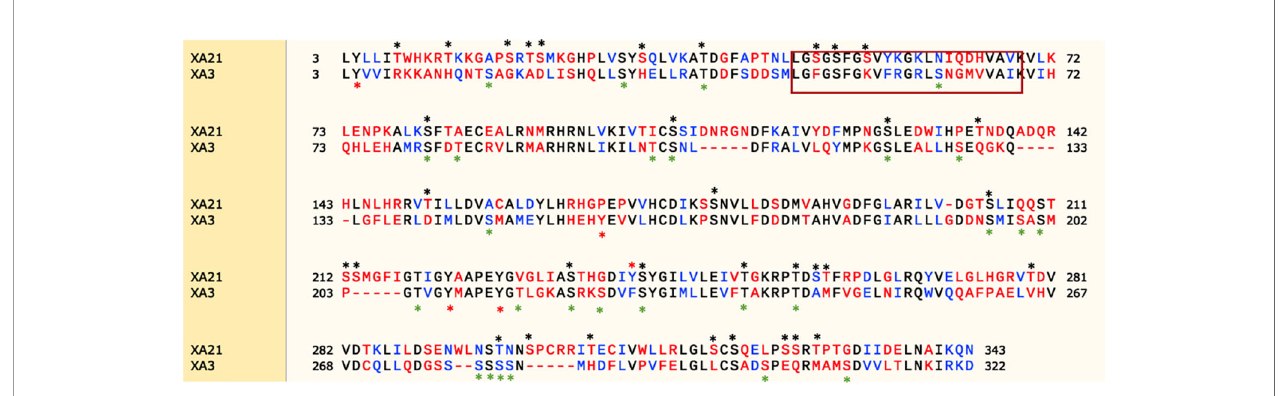
FIGURE 8 | Protein sequence alignment of the XA21 and XA3 intracellular kinase domains. Snapgene (SnapGene software from GSL Biotech; available at snapgene.com) was used for sequence alignment and NetPhos 3.1 (Blom et al., 2004) was used to predict the phosphorylation sites. The red box represents the predicted ATP binding domain. Predicted serine/threonine or tyrosine phosphorylation sites are marked with a “ * ” above